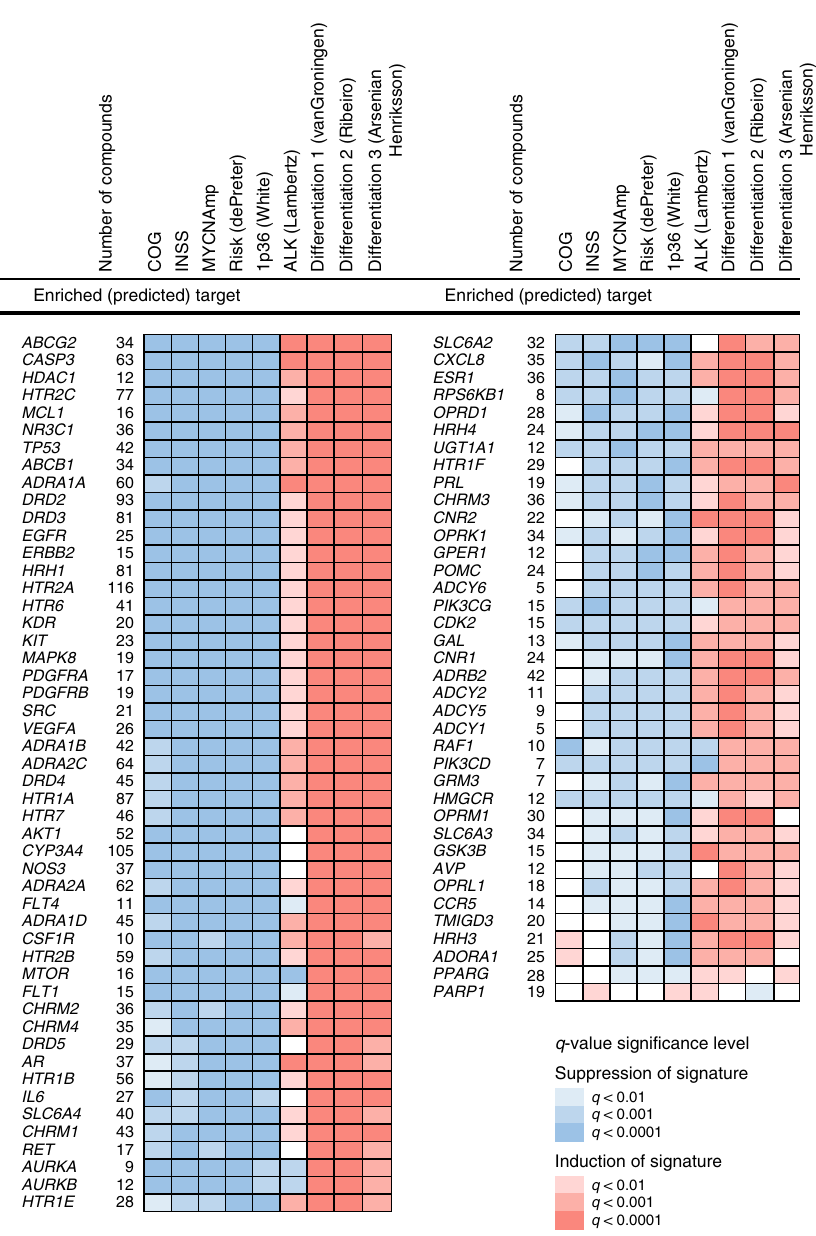
Fig. 3 Drug targets predicted by TargetTranslator for neuroblastoma signatures. 88 drug targets predicted by TargetTranslator. Red: target is associated with induction of signature; Blue: target is associated with suppression of signature. Shades represent strength of q